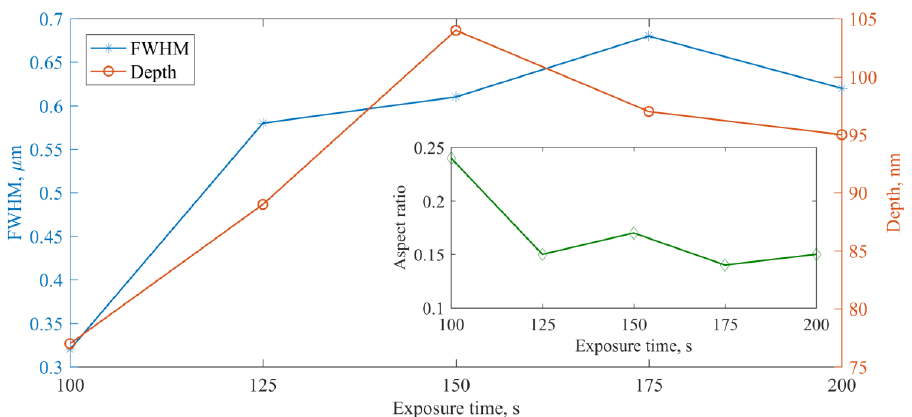
Figure 3. Variation of Full Width of Half Maxium (FWHM) and depth of the holes with respect to exposure time at constant laser beam power. Inset shows the variation of aspect ratio with respect to exposure time. exposure time.